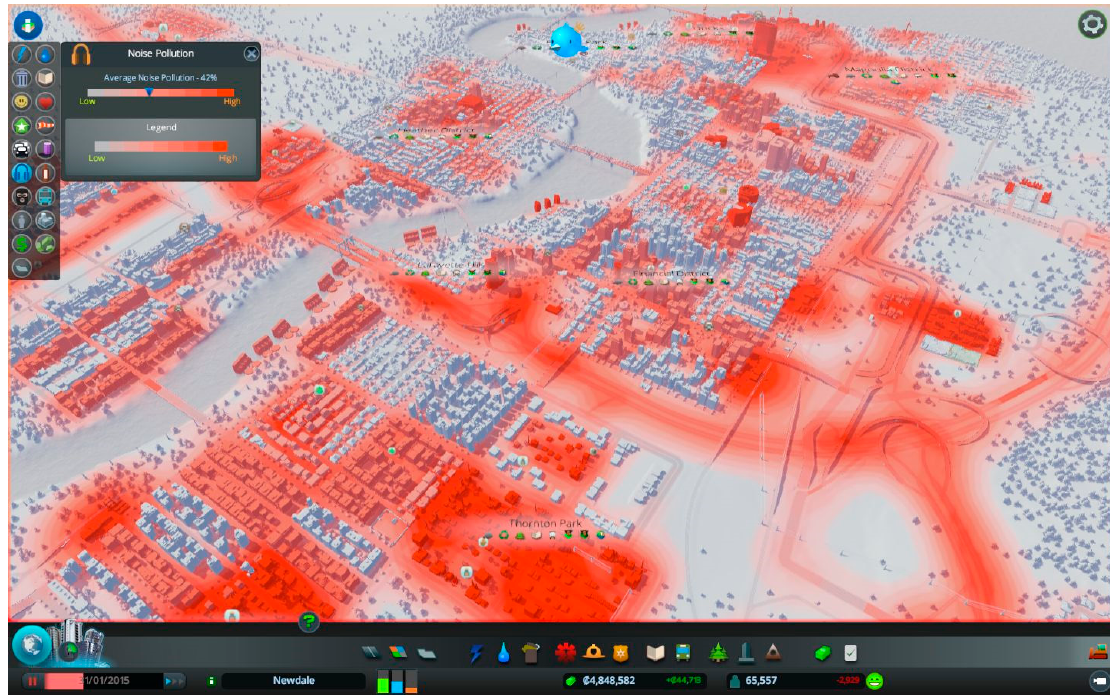
Figure 1. Example of a Cities: Skylines info view displaying the simulated noise pollution [34].